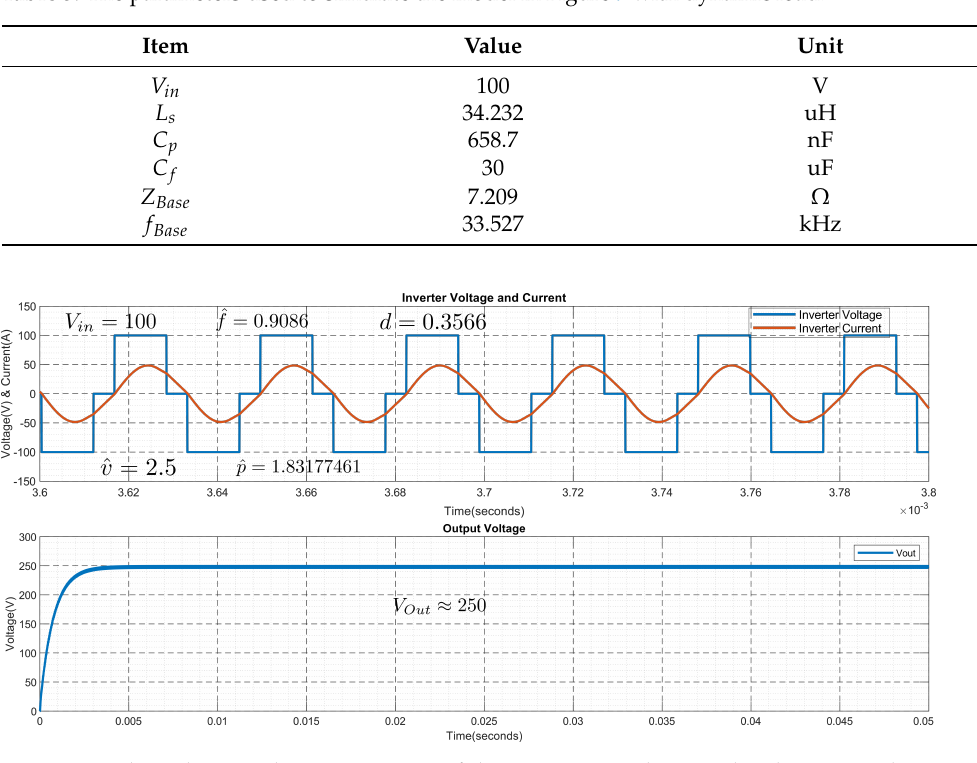
Figure 10. The voltage and current output of the converter with normalized output voltage and normalized power as